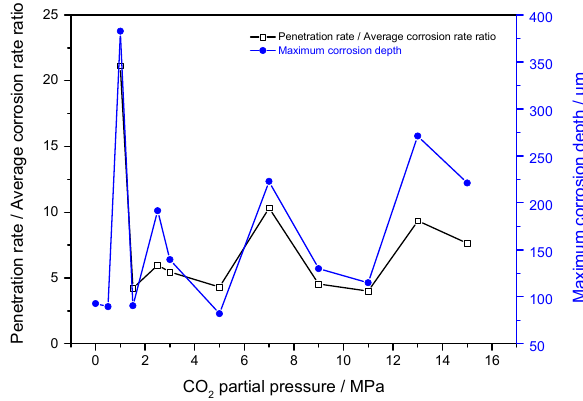
Figure 13. Maximum corrosion depth and penetration rate/average corrosion rate ratio of J55 carbon steel surface as a function of CO 2 partial pressure in 30% crude oil/brine mixtures.